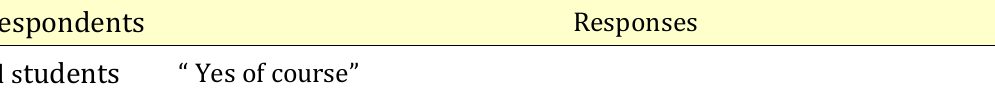
Table 1. Students from the 5th semester of English Education’s response .